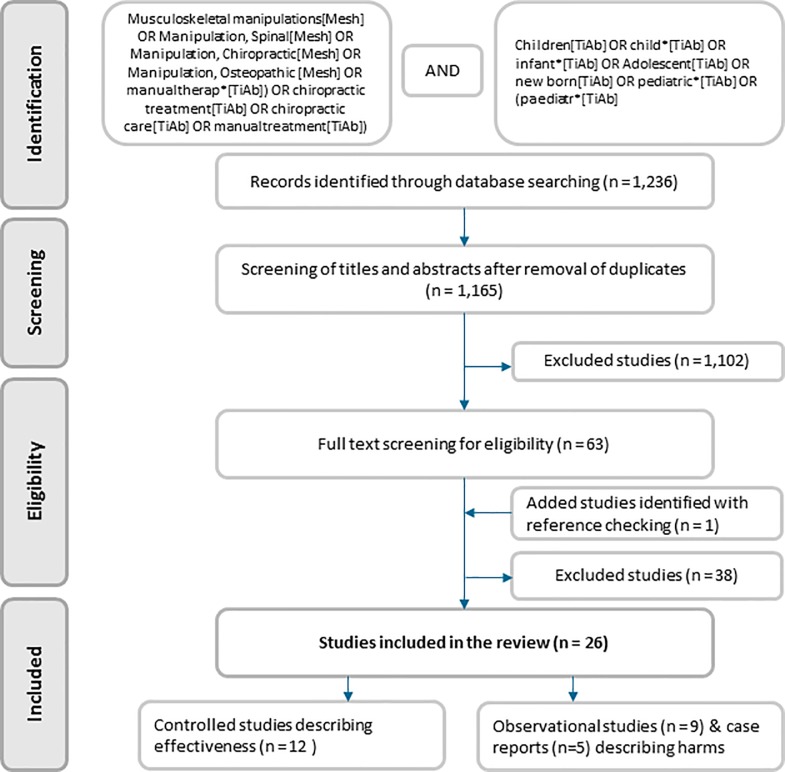
Flowchart search strategy.